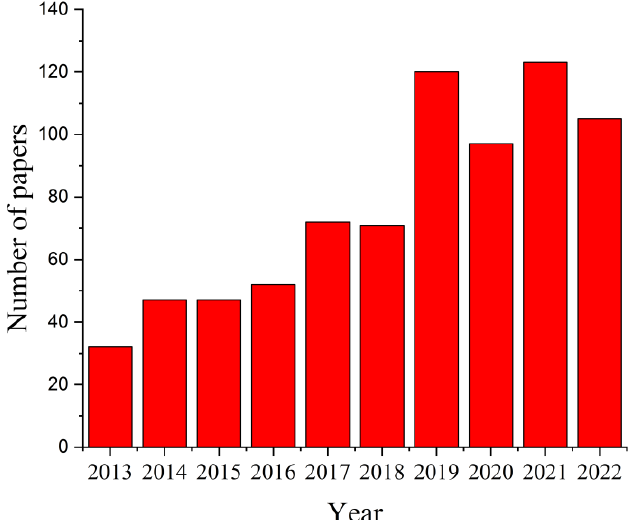
Figure 4. Statistical analysis results regarding the number of published papers between 2013 and 2022 that contain the search criterion “magnesium AND scaffolds”.